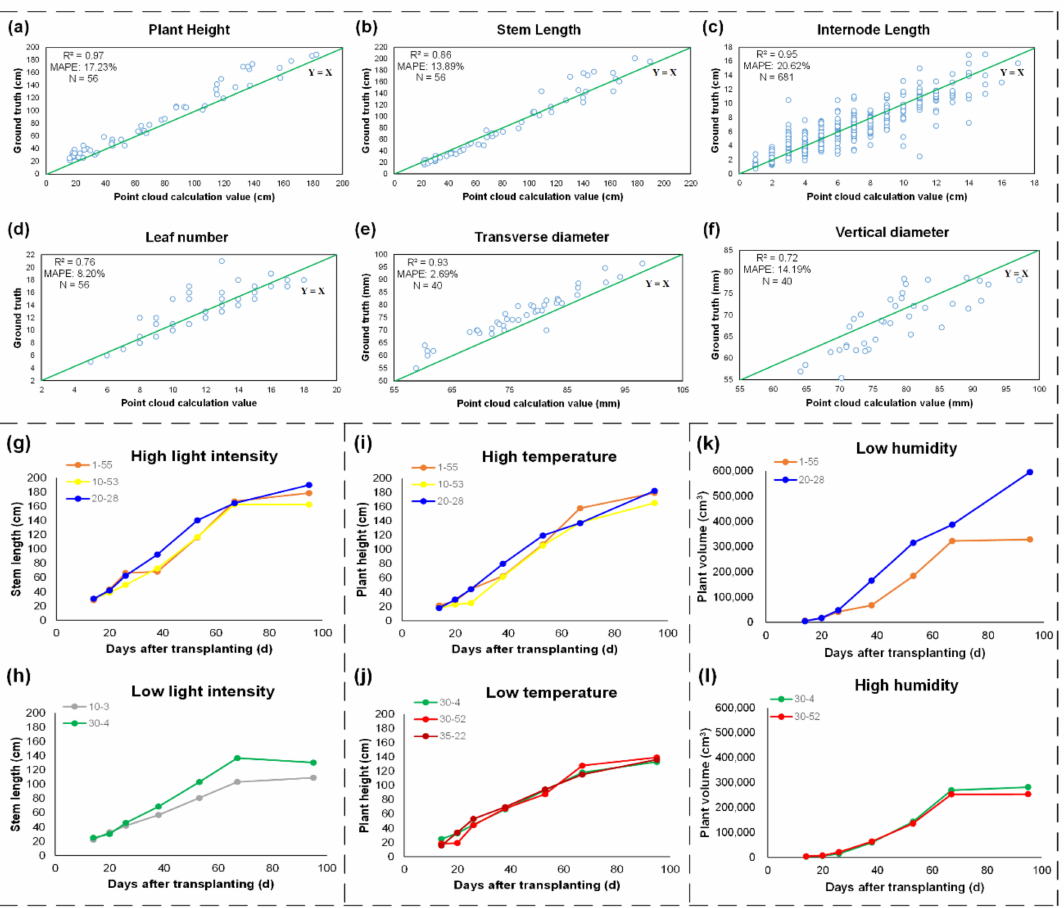
Figure 5. The performance evaluation of 3D trait extraction and growth variation with different environments. ( a ) Plant height, ( b ) stem length, ( c ) internode length, ( d ) leaf number, ( e ) trans- verse diameter, and ( f ) vertical diameter. ( g , h ) Influence of light intensity variation on stem length, ( i , j ) influence of temperature variation on plant height, ( k , l ) influence of humidity variation on plant